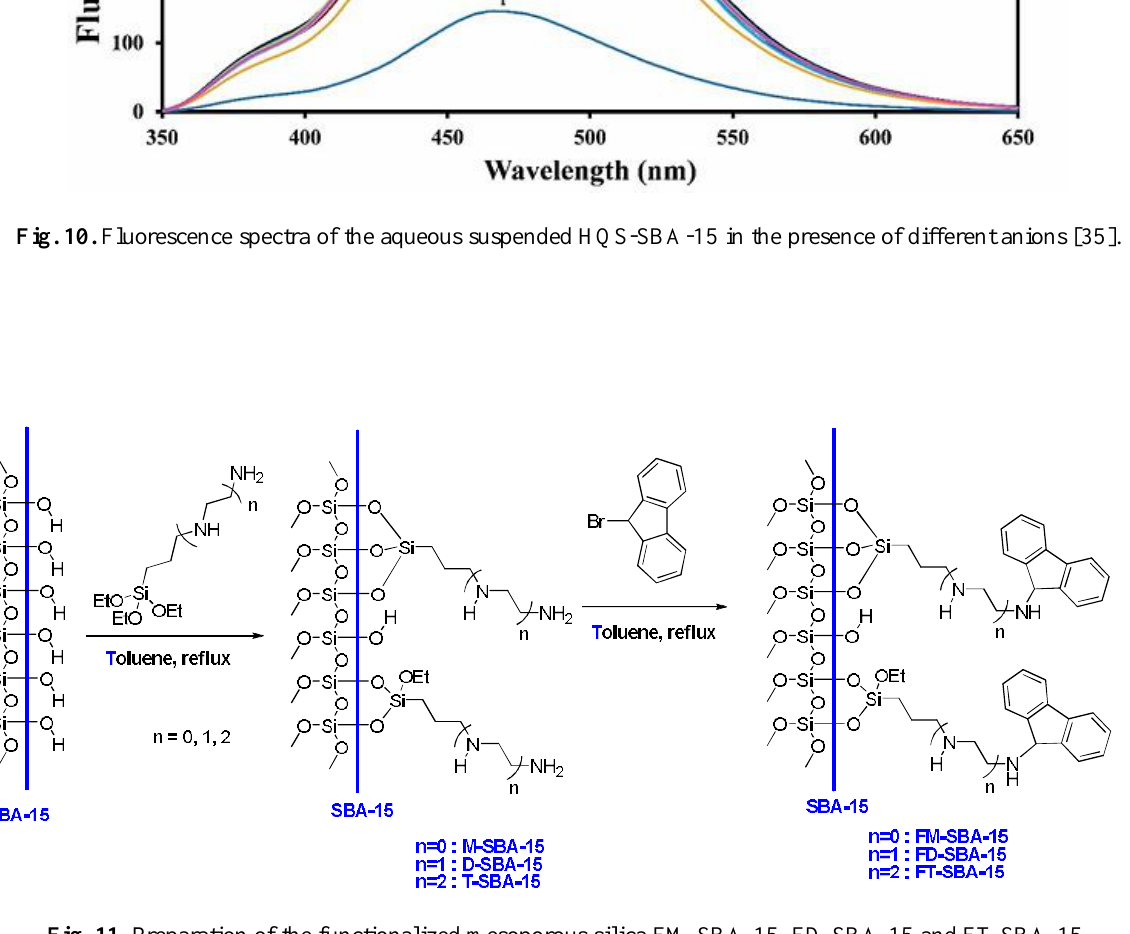
Fig. 11. Preparation of the functionalized mesoporous silica FM-SBA-15, FD-SBA-15 and